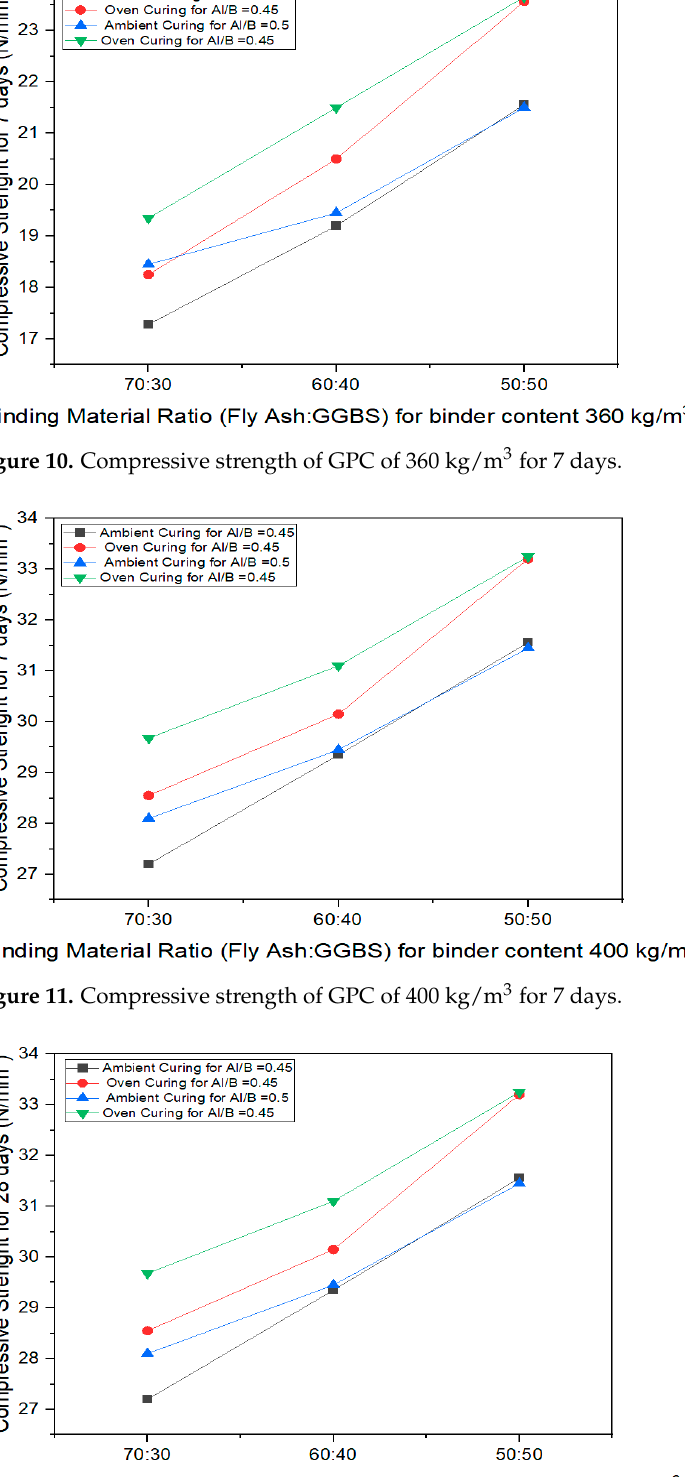
Figure 12. Strength of GPC of 360 kg/m 3 for 28 days.